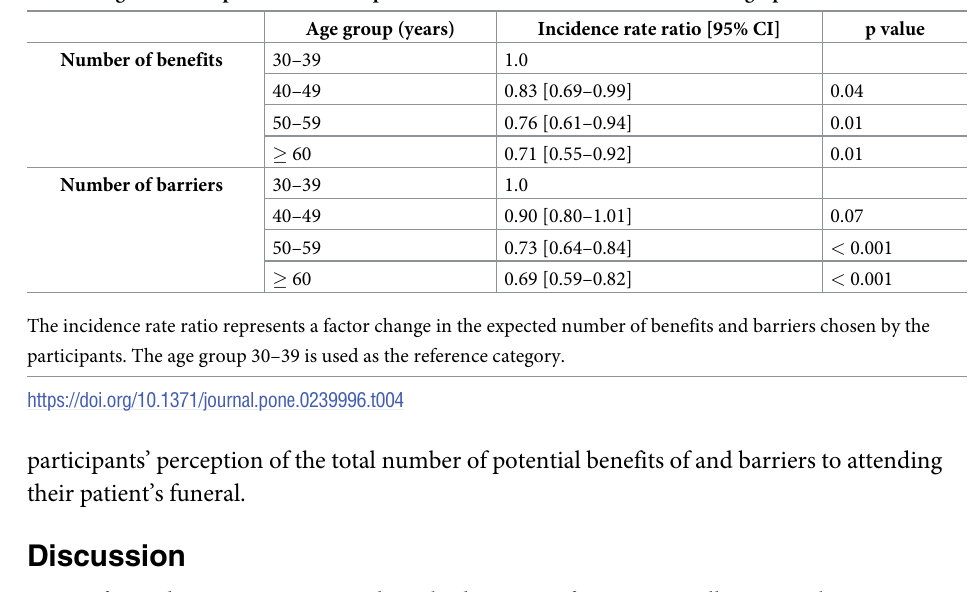
Table 4. Age and the expected number of perceived benefits of and barriers to attending a patient’s funeral.